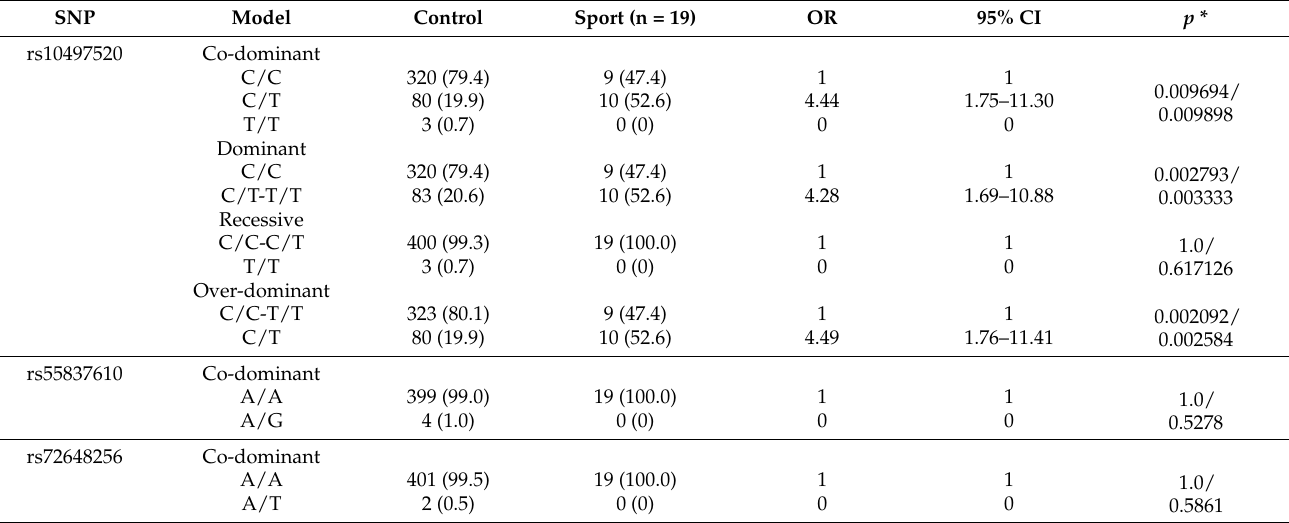
Table 6. Single SNP association analysis for cases (sprint/power sports, high elite) and